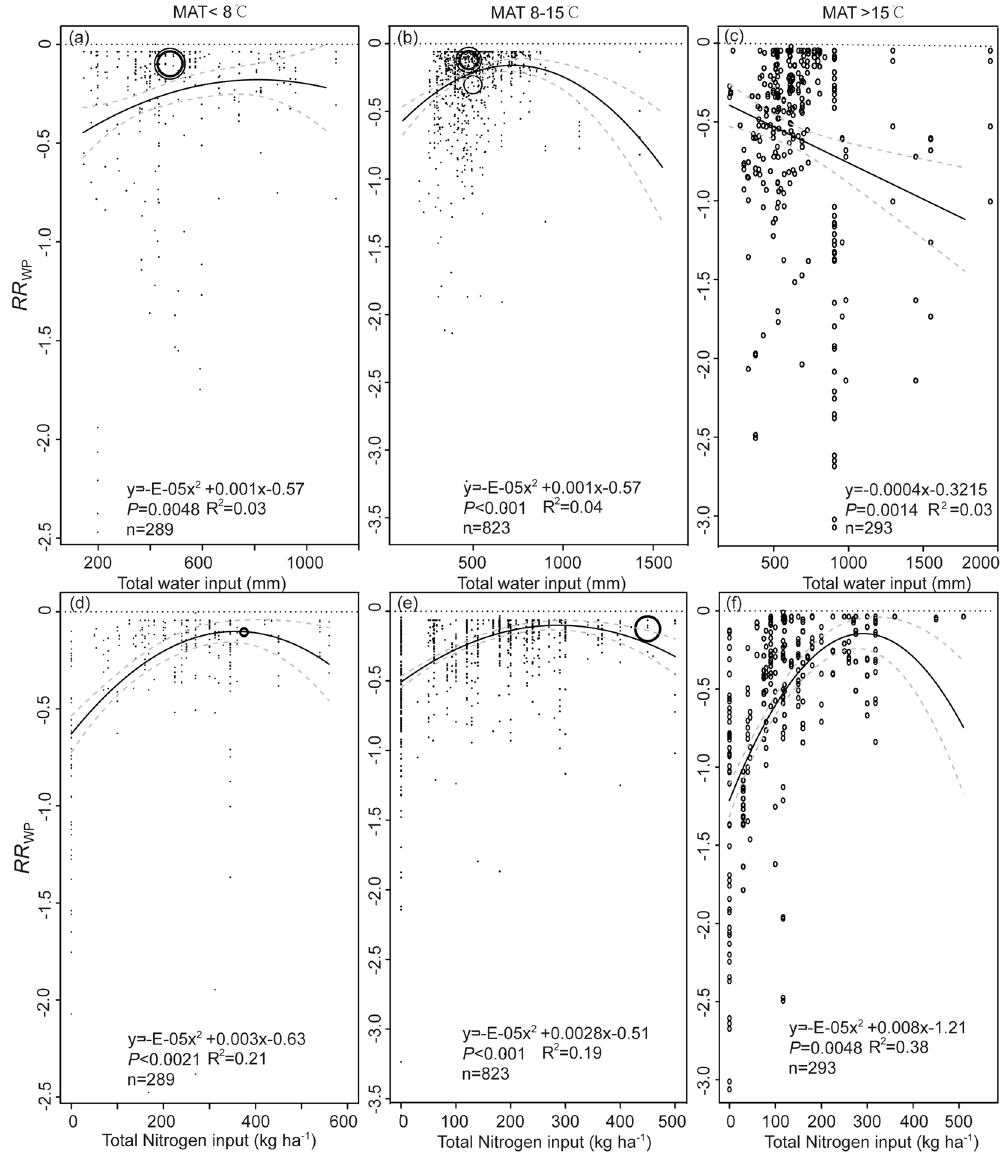
Figure 5. Scatter plot of response ratio of water productivity ( RR WP ) to water input when mean annual temperature (MAT) is ( a ) < 8 °C, ( b ) 8–15 °C, or ( c ) > 15 °C; to nitrogen input when MAT is ( d ) < 8 °C, ( e ) 8–15 °C, or ( f ) > 15 °C. Response ratio stands for effect size between the treatment and control and is calculated using Eq. 3. The solid black line represents the weighted regression line based on variance-weighted least squares. The grey line shows the 95% CI around the regression line. The circles indicate the response ratio of each observation. The circle size is proportional to the precision of the response ratio. Note the different scales among the